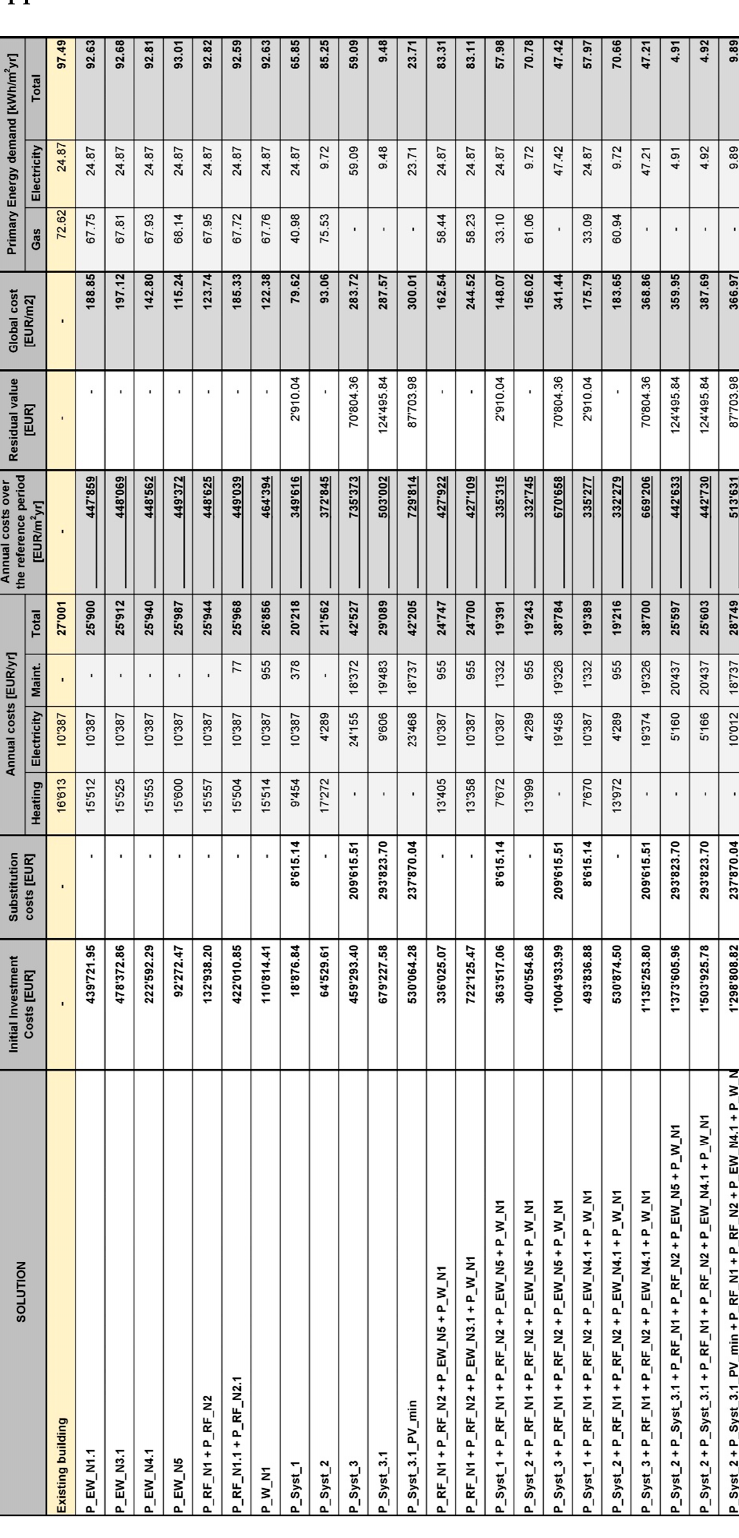
Figure A1. Summary table of cost-optimal methodology for financial scenario with discount rate equal to 4% for Poliziano school.